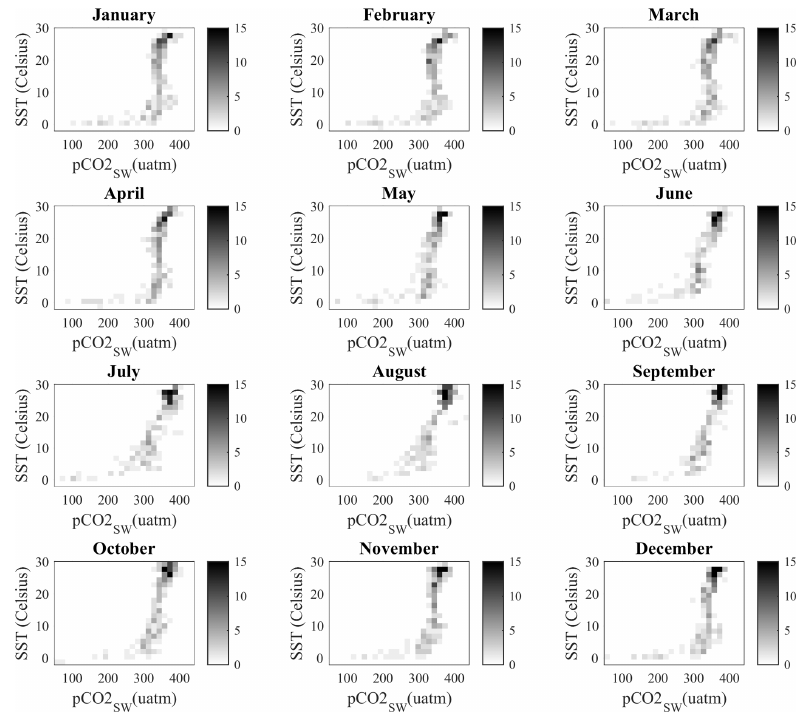
Figure 2. Monthly 2-D histograms of partial pressure of CO 2 in the surface water ( p CO 2sw ) and sea surface temperature (SST) in the North Atlantic (defined as 80 ◦ W to 45 ◦ E, 0 to 90 ◦ N) from the Takahashi observational dataset. The horizontal axis is p CO 2sw (uatm) and the vertical axis is SST ( ◦ C). The bin interval is 15uatm and 1.6 ◦ C. The color bar describes the actual frequency of occurrence of each